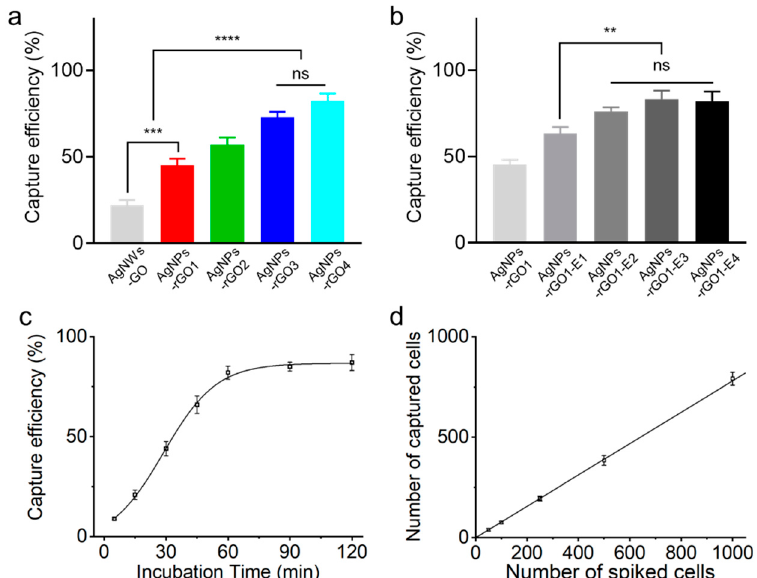
Figure 4. Capture efficiency of MCF7 cancer cells on the various AgNPs-rGO composite substrates with different GO weight ratios. ( a ) Fabricated with different applied electric fields; ( b ) Capture efficiency of MCF7 cancer cells on the AgNPs-rGO1-E4 substrate at different incubation times and ( c ) according to different cell concentrations; ( d ) Data representing the mean ± standard deviation (n = 3, ** p < 0.05, *** p < 0.01 and **** p < 0.001; one-way analysis followed by Tukey’s test).